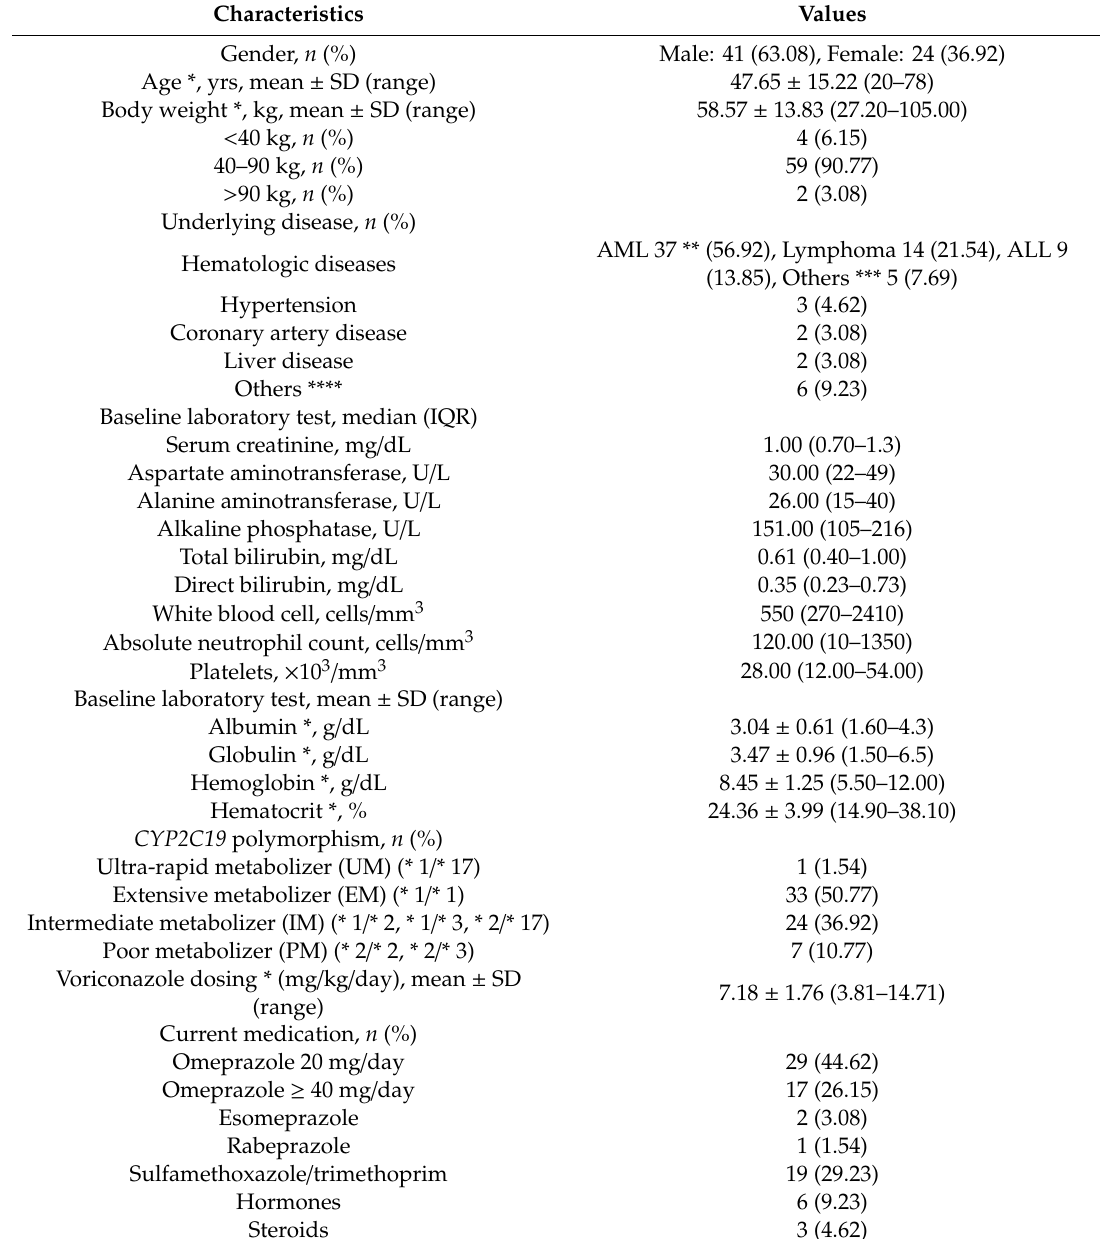
Table 1. Baseline demographic and clinical characteristics of study patients ( n =